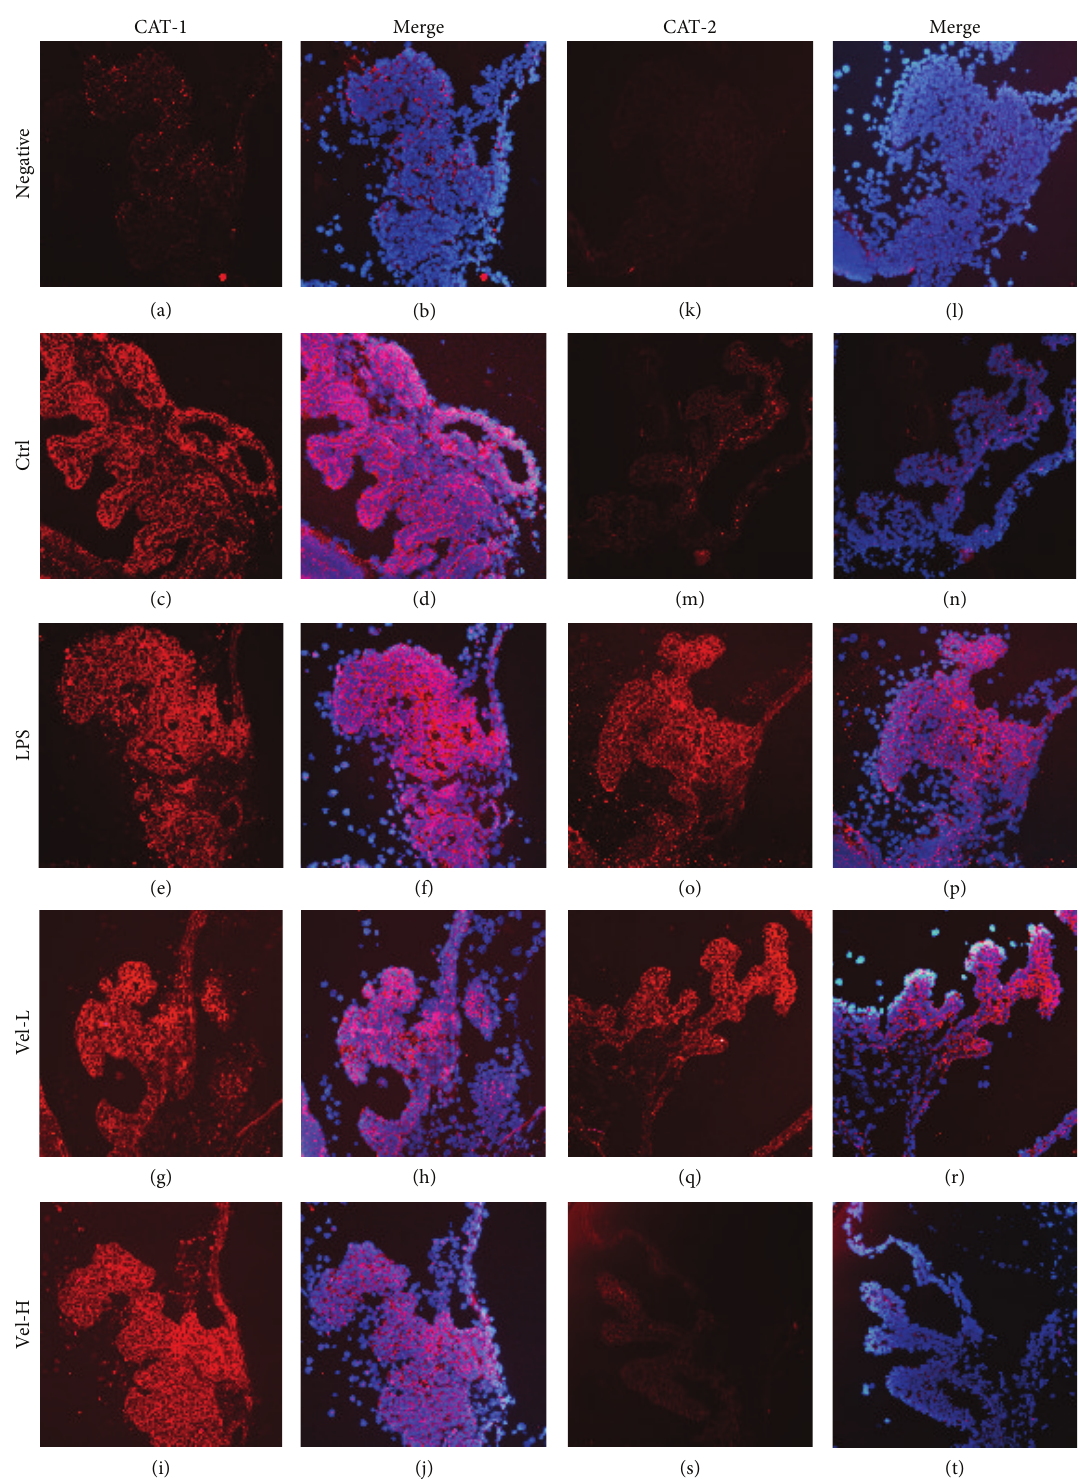
Figure 2: Expression of CAT in the iris and ciliary bodies detected by immune-fluorescence staining. Vel-L = low-dose bortezomib; Vel-H = high-dose bortezomib; CAT-1 and CAT-2 were immunostained as red. In the “Merge” column (b, d, f, h, j and l, n, p, r, t), all of the slices were counterstained with DAPI (4 󸀠 ,6-diamidino-2-phenylindole) that stains blue for better iris-ciliary body tissue visualization. CAT-1 was extensively expressed in the ICBs of all the treatment groups (c, e, g, and i), whereas CAT-2 was expressed only in the LPS- (o) and low-dose bortezomib-treated groups (q). High-dose bortezomib (s) treatment reduced the CAT-2 expression in the ICBs of EIU rats. Scale bar = 50 𝜇